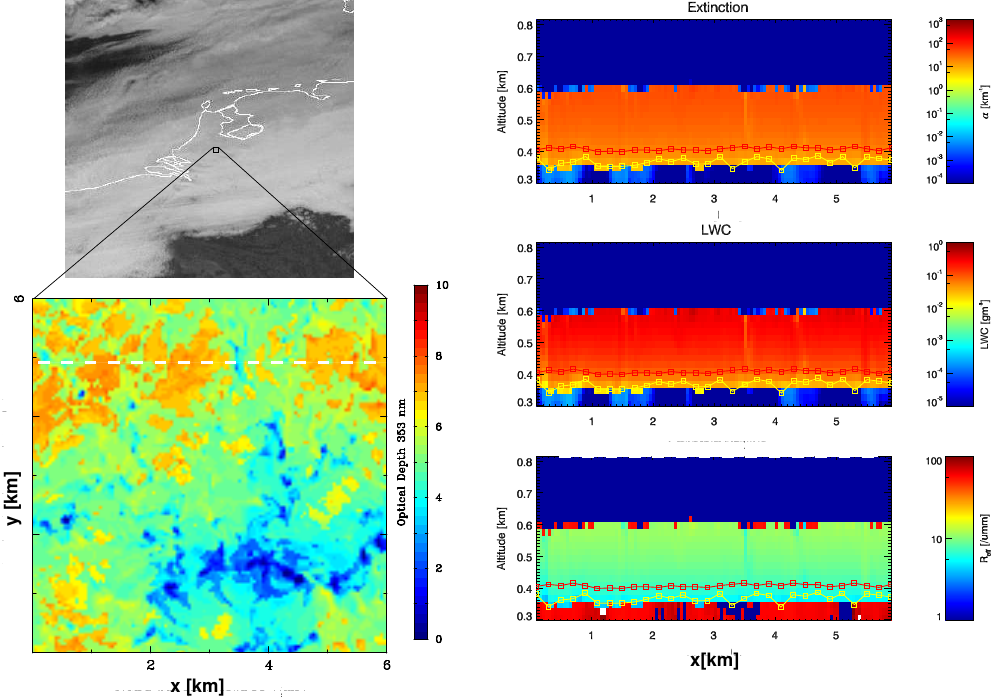
Figure 8. Visible MetoSat-SG Satellite image (top left) cloud optical thickness (COT) field for an DALES simulation for the Cabauw measurement site (bottom left) for the afternoon of 30 January 2011. Vertical extinction, LWC and effective radius slices corresponding to the “ y ” = 5km line indicated on the COT plot (right panels). The red lines in the right panels indicate the peak of the simulated lidar parallel attenuated backscatter while the yellow lines indicate the cloud base returned by the retrieval